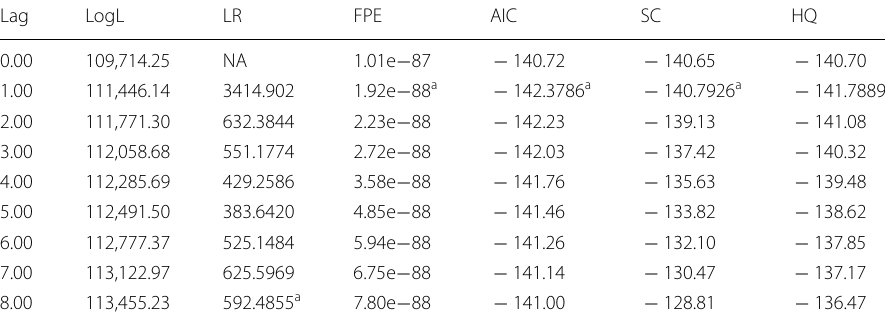
Table 5 VAR lag order selection criteria